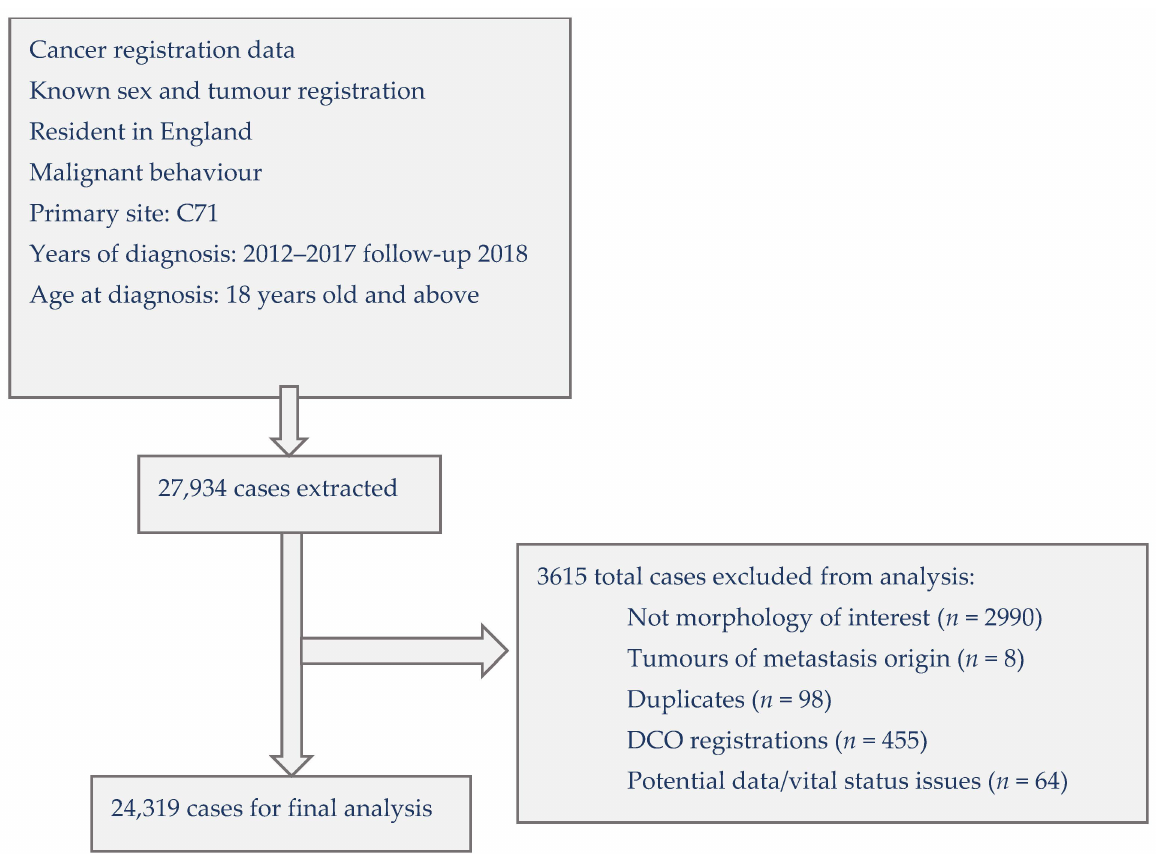
Figure 1. Selection of cases for analysing the influence of ethnicity on malignant primary brain tumour survival in England, 2012–2017 with follow-up to 2018 (DCO = Death Certificate